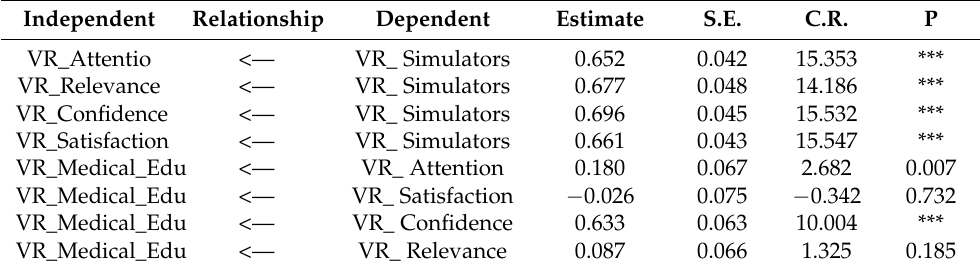
Table 5. Regression weights: maximum likelihood estimates.